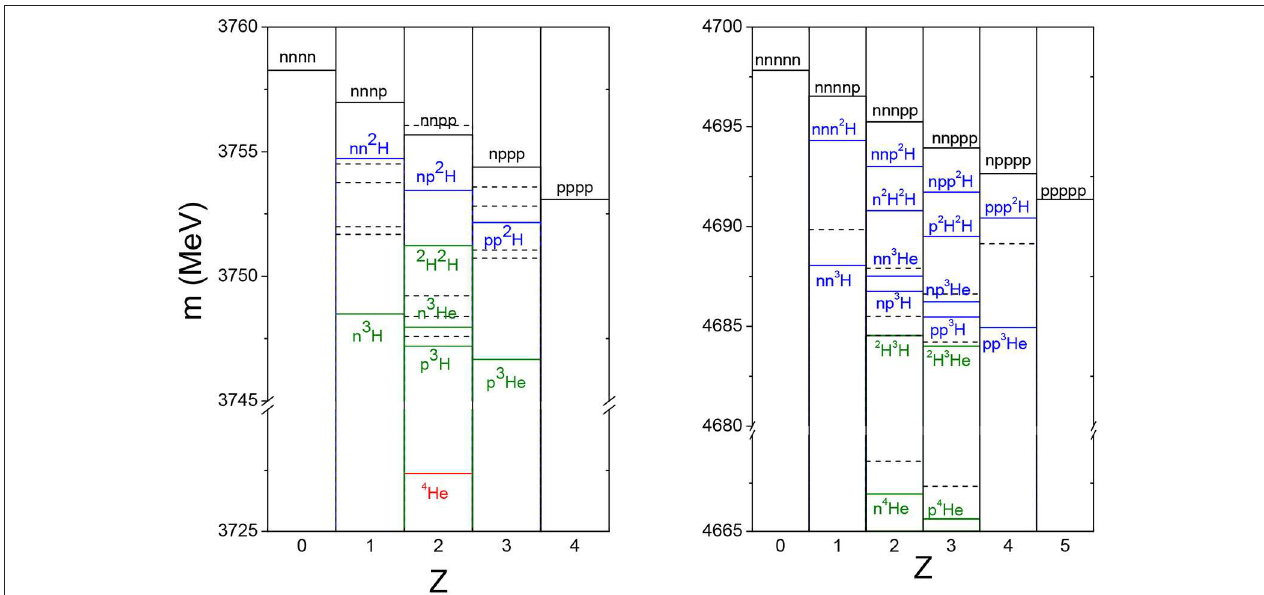
FIGURE 1 | Schematic nuclear chart for A = 4 (left) and A = 5 (right) systems displaying the different thresholds (full lines). The two-cluster thresholds are depicted in an olive color, many-cluster thresholds in blue and black. Some selected resonant states are depicted by dashed lines, indicating approximate positions of their centroids, as predicted by R-matrix analysis by Tilley et al. [24] and Tilley et al. [25]. The widths of the resonant states are disregarded.